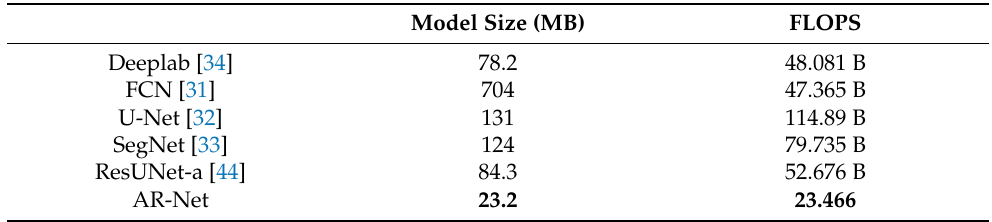
Table 4. The model parameter size of the six semantic segmentation algorithms. The bold numbers represent the minimum value in each column.